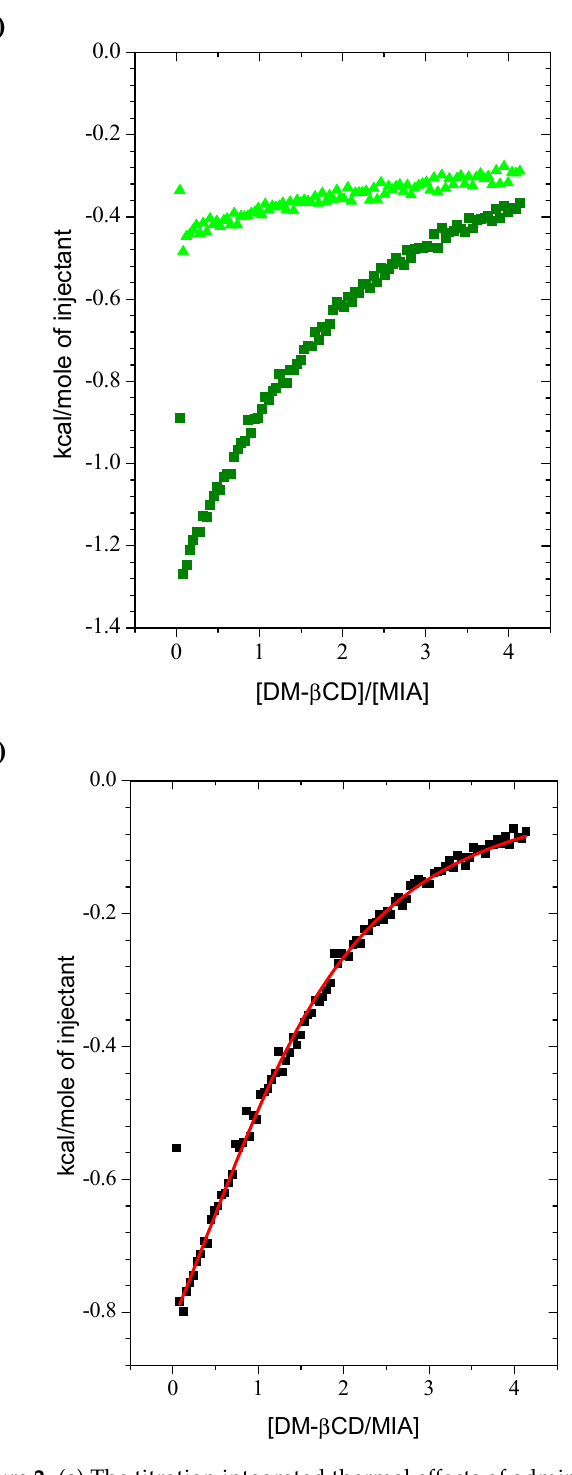
Figure 2. ( a ) The titration integrated thermal effects of administration of a 15 mM DM- β -CD solution (in a syringe) to a 0.79 mM MIA solution (in a cell) at 298.15 K under atmospheric pressure p = 101,000 Pa ( ■ ) and dilution of 15 mM DM- β -CD solution in water ( ▲ ); ( b ) the integrated heat of interaction between MIA and DM- β CD molecules ( ■ ) corrected by the heat of the correspondent dilution. The solid red line represents the best non-linear least squares fit to a mathematical model of “One set of binding sides” [17,23].